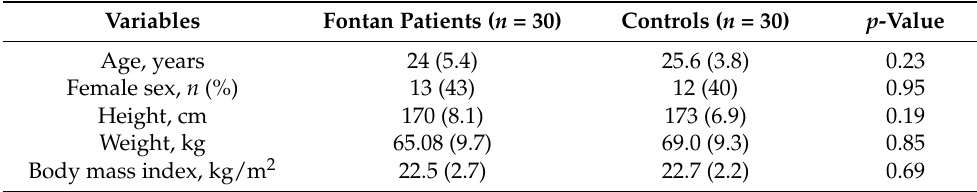
Table 1. Baseline characteristics of the study group and controls.